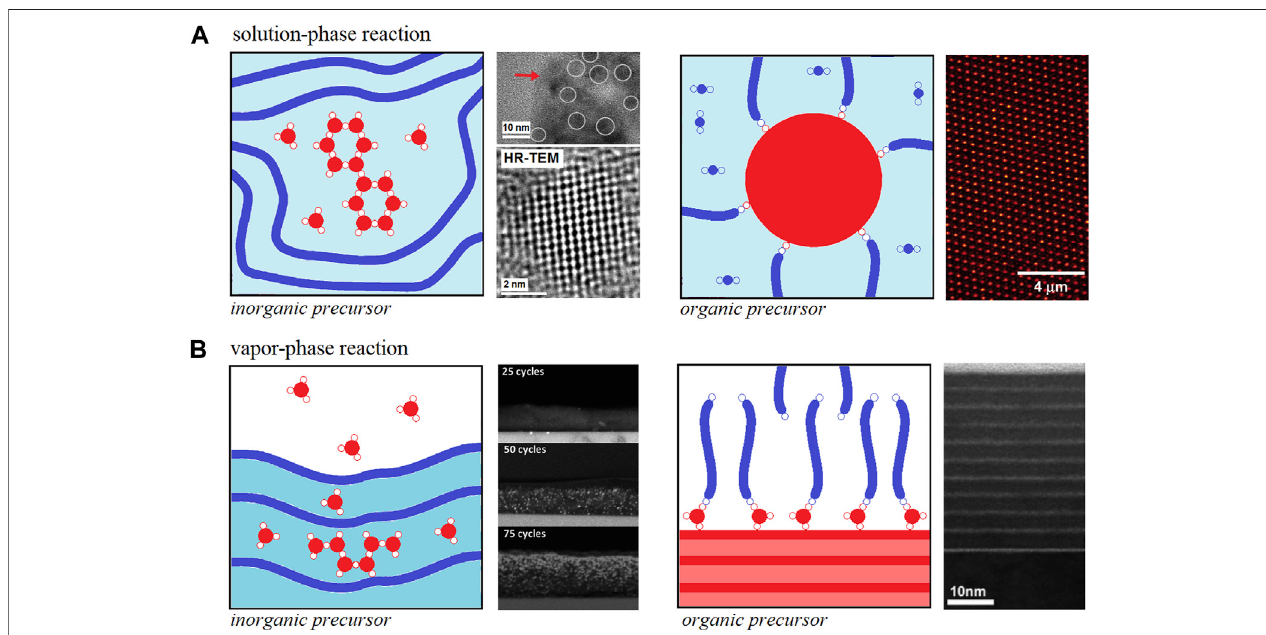
FIGURE 1 | Schematic representation for (A) solution-phase and (B) vapor phase reactions to obtain h OI materials. Both cases include the preparation of h OI materialsatexpensesofinorganicprecursorsgrowthinthepresenceoforganicpolymerhost(leftpanels)andusingorganicprecursorspolymerizationinthepresenceof inorganic clusters/nanoparticles or surfaces (right panels). Each panel also includes: HRTEM images for PANI-TiO 2 prepared via solution-phase reaction of titanium propoxide and polyaniline with further exposure to water vapor (A, left panel) [ Portions of fi gures adapted/altered minimally with permission from Elsevier ] (Mombrú et al., 2017a), confocal laser scanning microscopic images for PMMA-SiO 2 prepared via surface-initiated atom transfer radical polymerization of MMA (A, right panel) [ Portion of fi gure adapted/altered minimally with permission from American Chemical Society ] (Ohno et al., 2006), Cross-section HRSEM images for P3HT-ZnO fi lms obtained after 25, 50, 75 diethylzinc/water ALD cycles (B, left panel) [ Portions of fi gure adapted/altered minimally with permission from Royal Society of Chemistry ] (Obuchovsky et al., 2014). Cross-section HRTEM images of self-assembled organic multilayer/TiO 2 nanolaminate fi lms made by using sequential ALD/MLD cycles of titanium isopropoxide and 7-octenyltrichlorosilane vapors, respectively (B, right panel) [ Portion of fi gure adapted/altered minimally with permission from American Chemical Society ] (Lee et al., 2007).